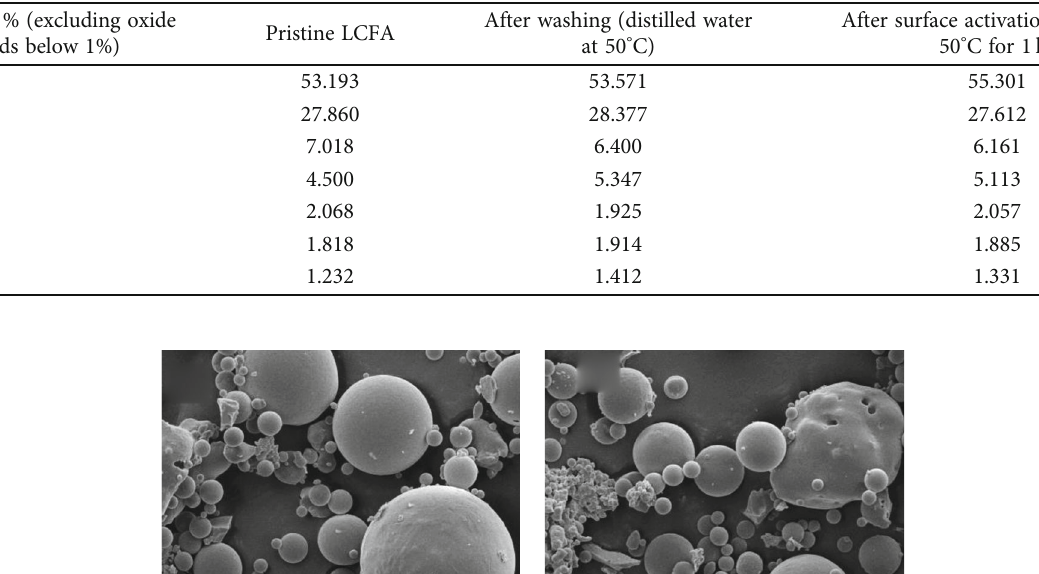
Table 1: Chemical content of LCFA before and after surface activation measured by